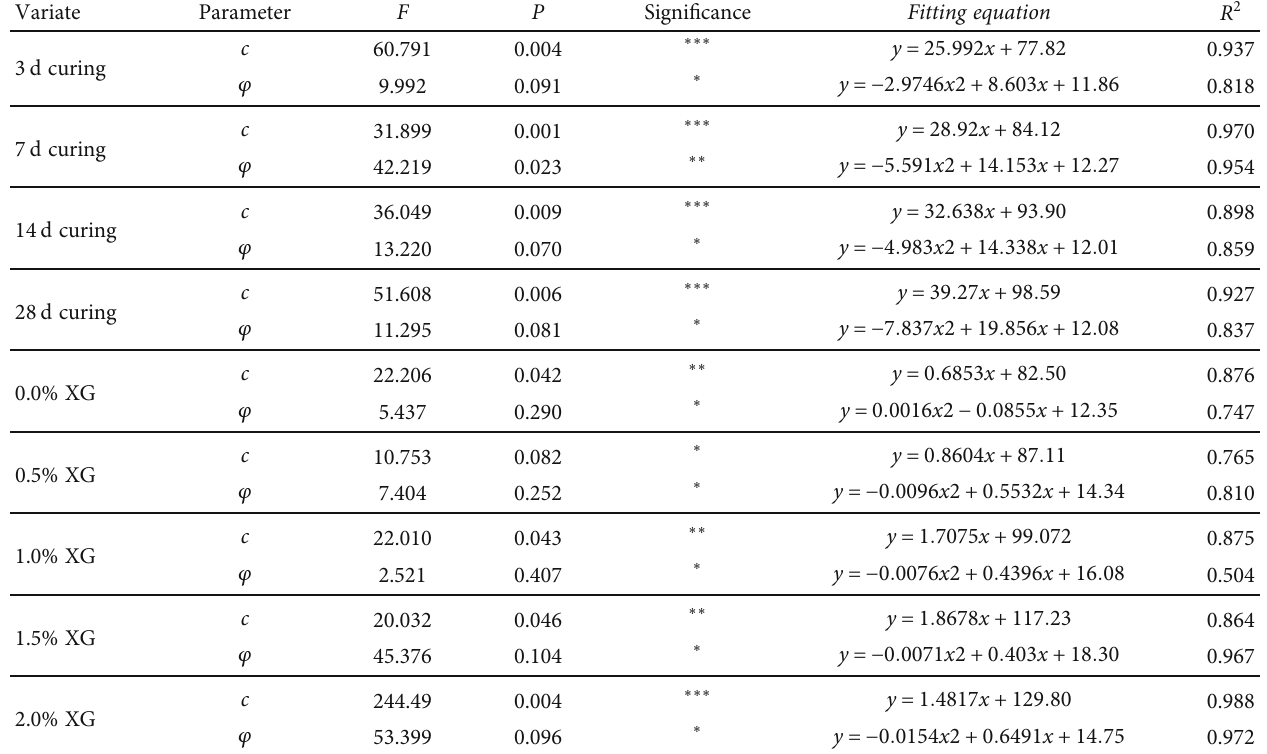
Table 6: Correlation analyses of the in fl uencing factors with shear strength parameters.